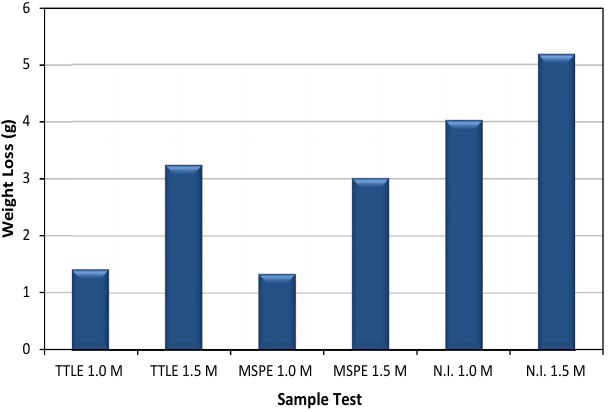
Fig. 3. Weight loss in HCl solution at room temperature after 18